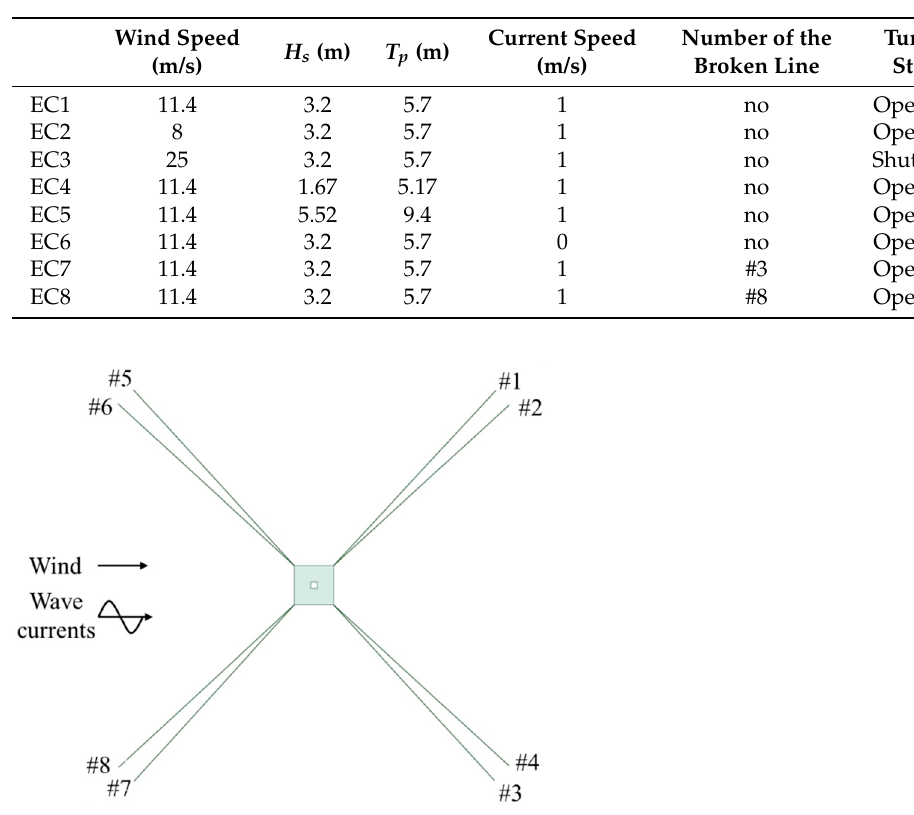
Table 5. Environmental conditions.